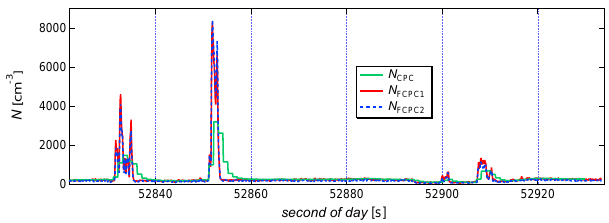
Figure 1. Time series of the two FCPC (FCPC1 and FCPC2) and the TSI CPC measured during a flight section on 22 April